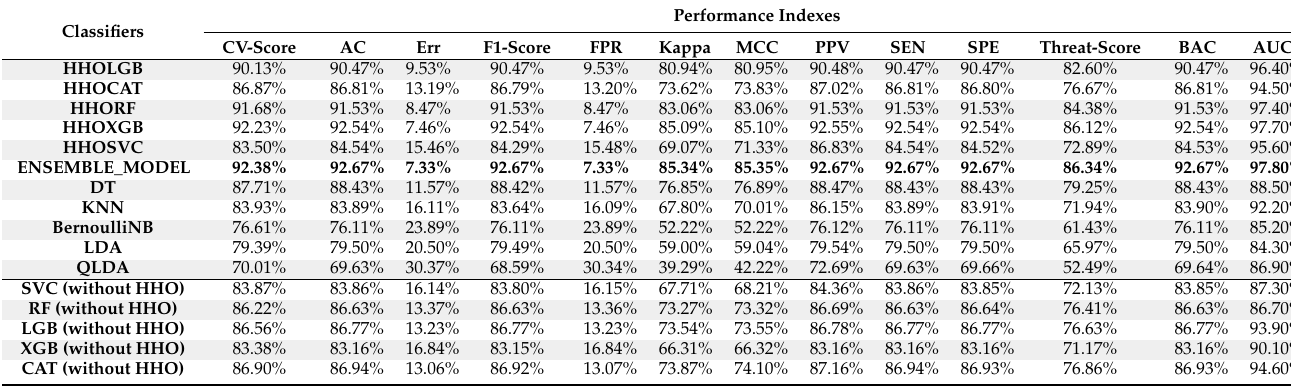
Table 3. Classification performance on COVID-19